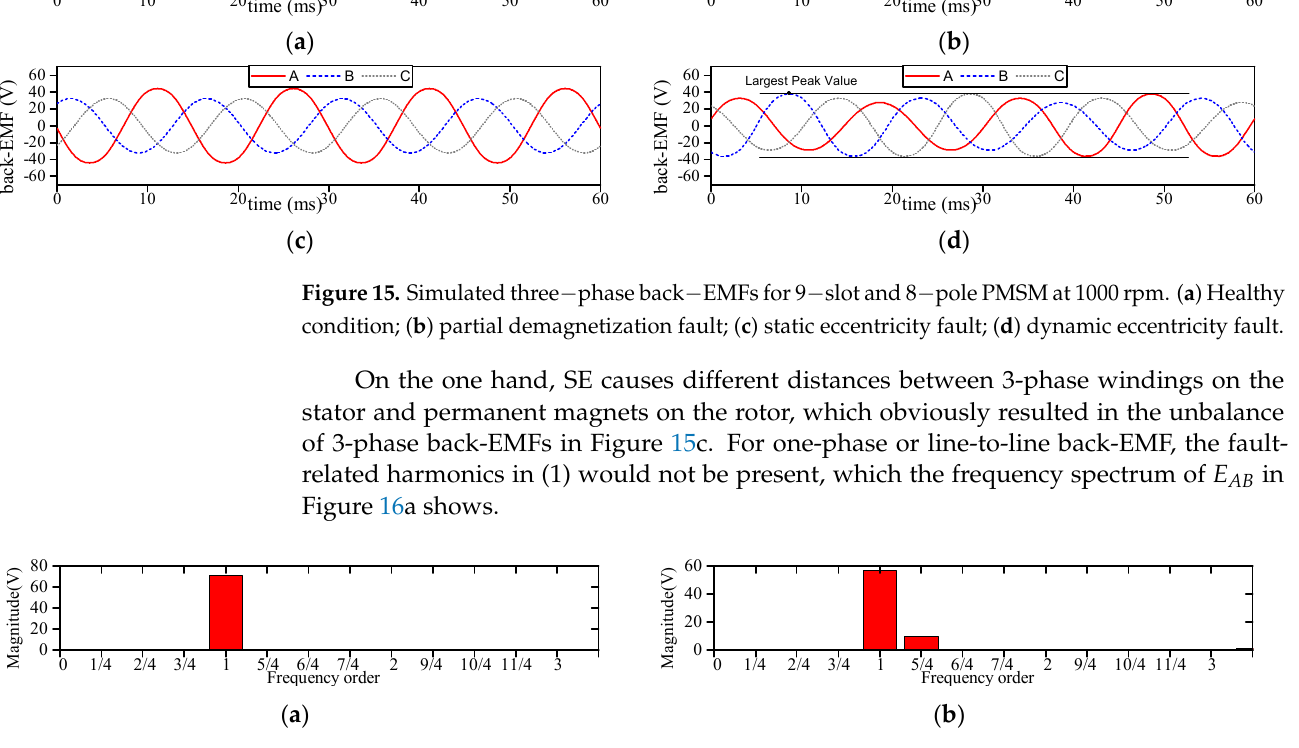
Figure 16. Frequency spectrum of EAB for 9 − slot and 8 − pole PMSM. ( a ) Static eccentricity fault at 1000 rpm; ( b ) dynamic eccentricity fault at 1000 rpm.